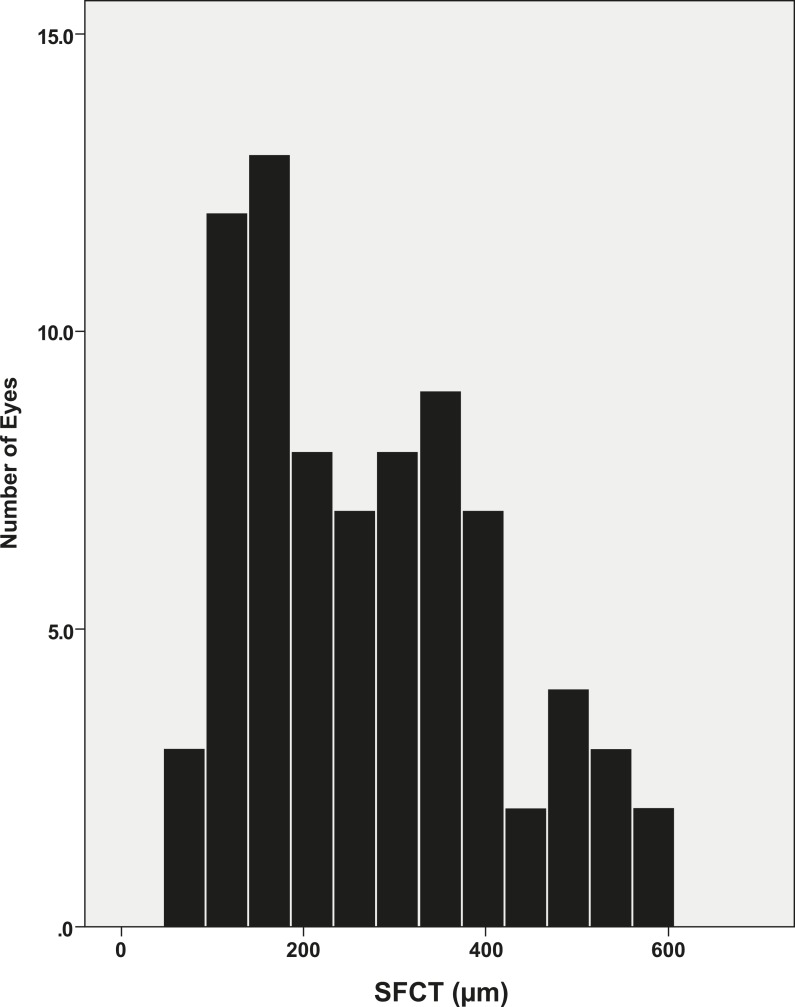
Distribution profile of subfoveal choroidal thickness in 78 eyes with polypoidal choroidal vasculopathy.SFCT: subfoveal choroidal thickness.